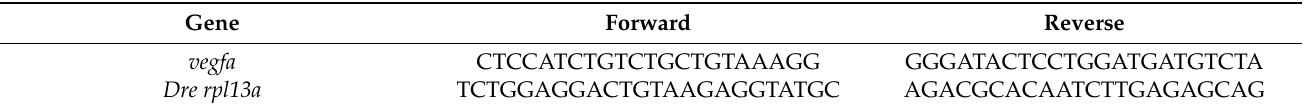
Table 1. Primer sequences.